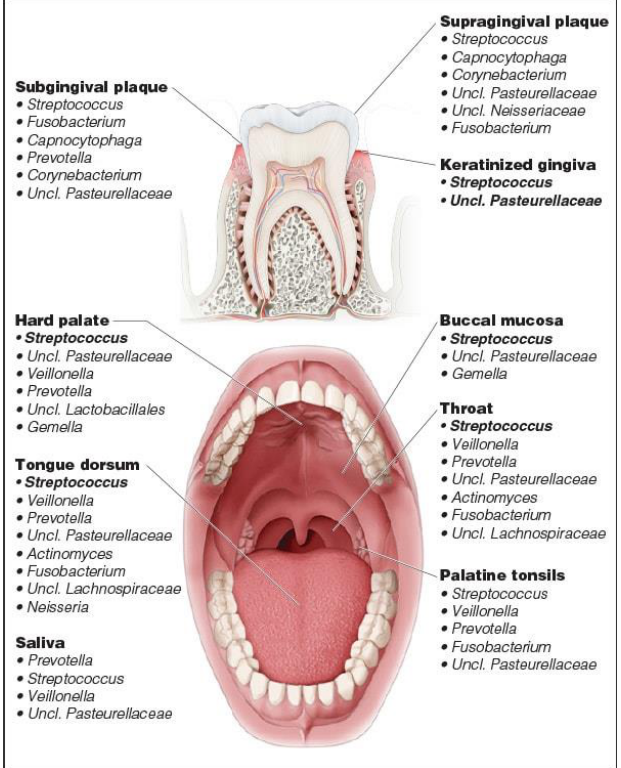
Figure 3. Microbial population in the oral cavity.